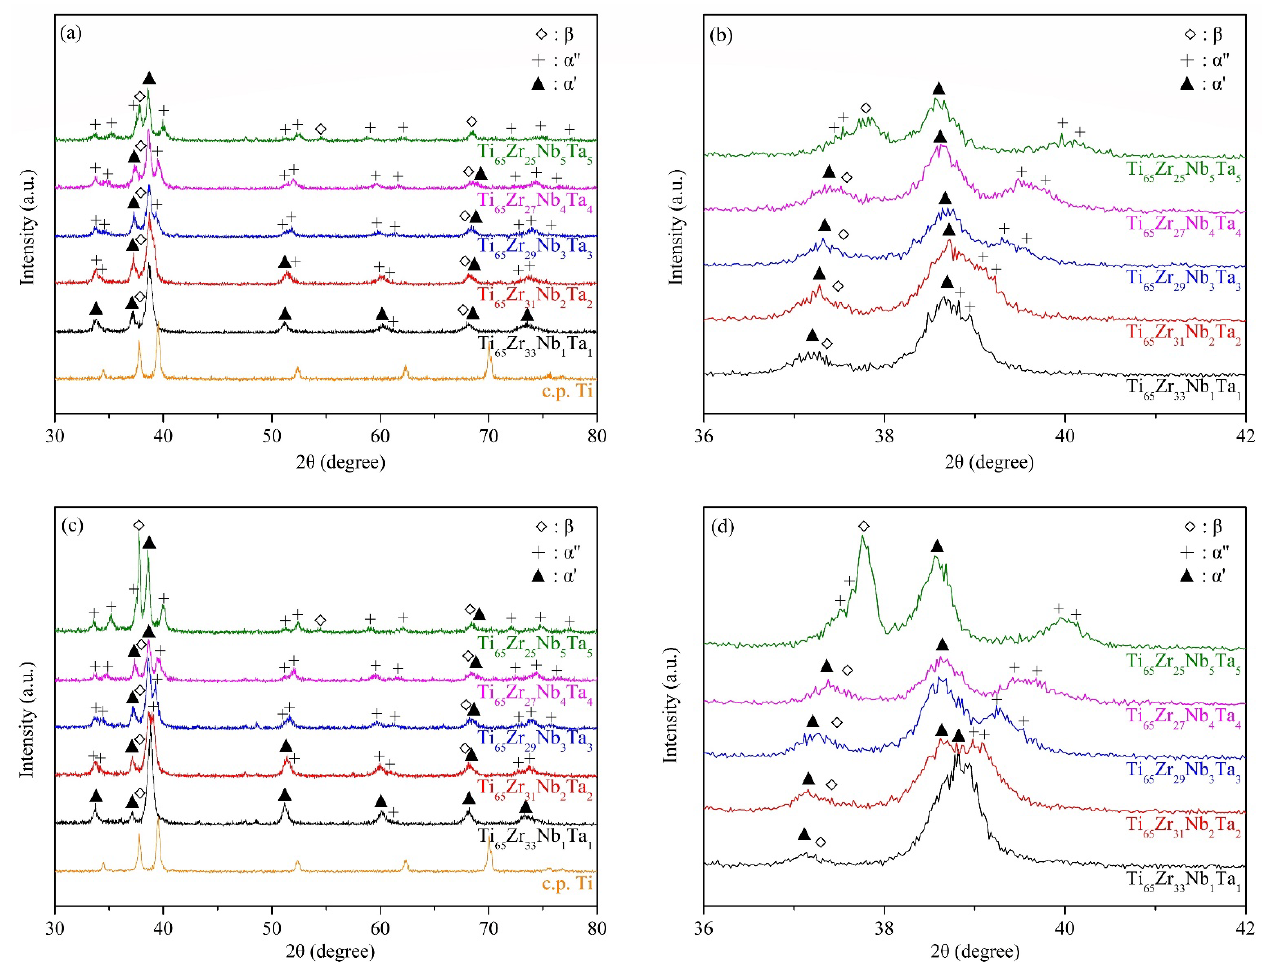
Figure 1. X-ray diffraction patterns of the Ti–Zr–Nb–Ta medium-entropy alloys (MEAs). ( a ) As cast (30–80°), ( b ) as cast (36–42°), ( c ) after solution treatment (ST) (30–80°), and ( d ) after ST (36–42°). The phase volume fractions of the five β + α (cid:48)(cid:48) + α (cid:48) MEAs before and after ST are listed in Figure 2. Ti 65 –Zr 33 –Nb 1 –Ta 1 had the greatest α (cid:48) -phase volume fraction because it had